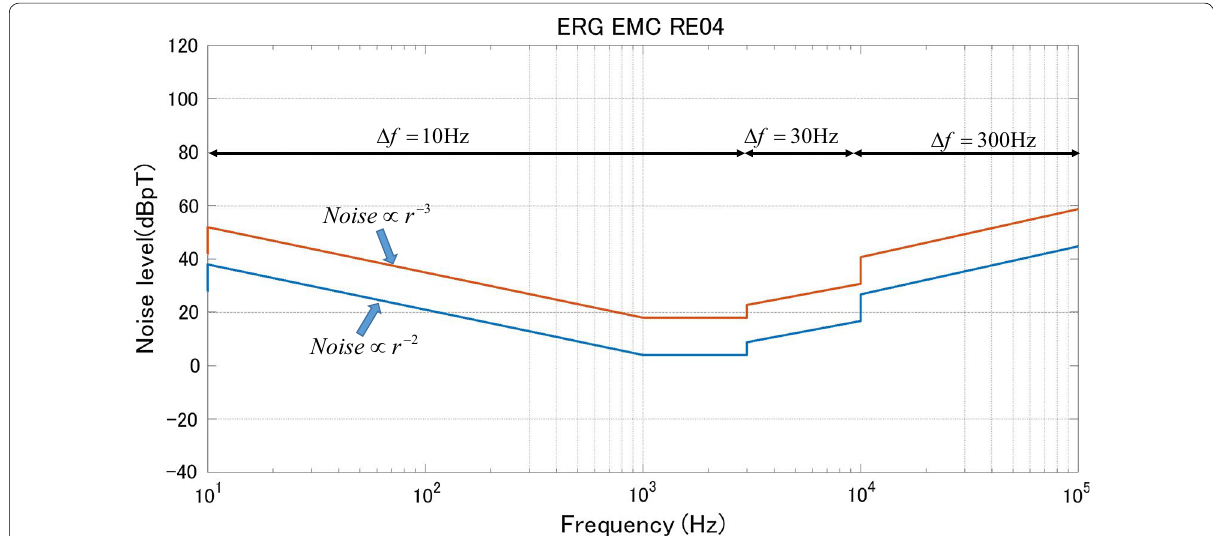
Fig. 17 Limit level for the electromagnetic compatibility (EMC) requirements of the radiated magnetic field noise